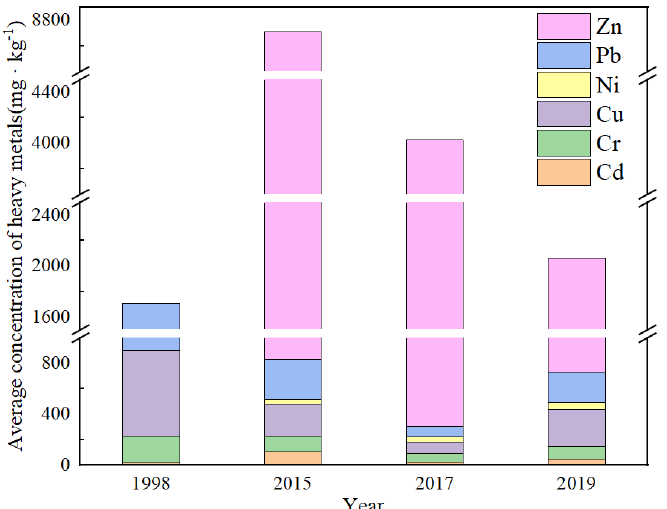
Figure 4. Change in heavy metal concentrations in the sediment from the Huafei River from 1998 to 2019.